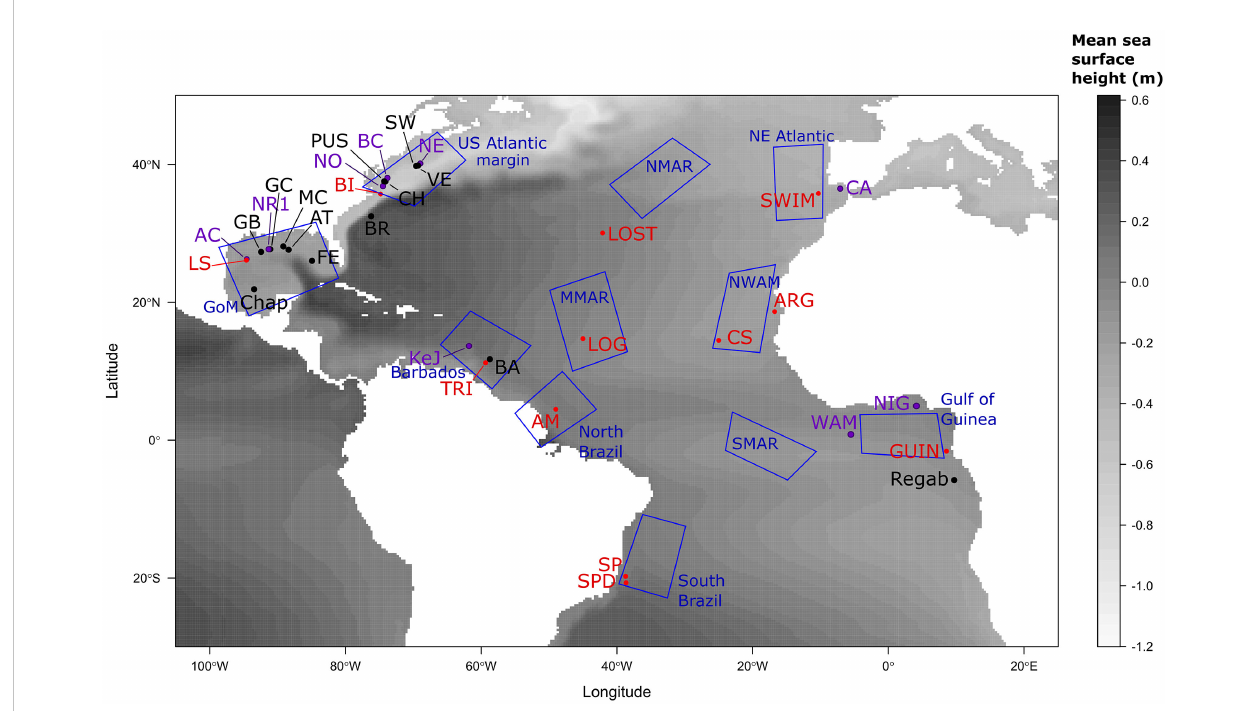
FIGURE 1 Geographic locations of seeps involved in the present study. Sites for which only genetic samples are available are in black, spawning areas used only in larval dispersal modelling are in red, sites used for both genetic and modelling approaches are in purple. Blue polygons represent settlement regions used in the modelling approach. Site abbreviations correspond to NR1, Brine Pool; LS, Louisiana slope; AC, Alaminos canyon; BI, Bodie island; NO, Norfolk canyon; BC, Baltimore canyon; NE, New England seeps; SWIM, SWIM Fault; CA, Gulf of Cadiz; ARG, Arguin bank; CS, Cadamostro seamount; NIG, Nigerian margin; WAM, West African margin; GUIN, Guiness; SP, Sao Paulo seep 1; SPD, Sao Paulo seep 2; AM, Amazon fan; TRI, Trinidad prism; KeJ, Kick em Jenny crater; LOG, Logatchev seep and LOST, Atlantis FZ (Lost City). Abbreviations of the zones for recruitment are: NWAM, North West African margin; NMAR, North Mid-Atlantic Ridge; MMAR, Middle Mid-Atlantic Ridge and SMAR, South Mid- Atlantic Ridge. Genetic samples were either obtained in the present study or included thanks to already published sequences (see Tables 1, 2;